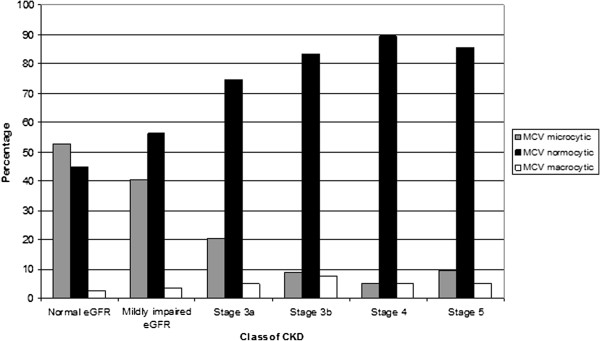
Micro-, normo-, and macrocytic anaemia for each stage CKD.